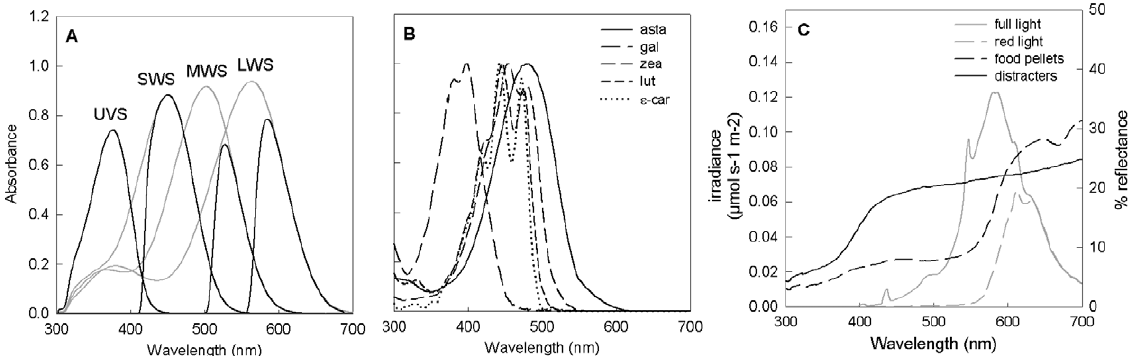
Figure 1. A comparison of carotenoid and visual pigment absorbance spectra, food and background reflectance, and irradiance spectra of the experimental lighting. (A) Absorbance spectra of single-cone photoreceptors before (gray lines) and after (black lines) carotenoid- pigmented cone oil-droplet filtering. Spectral sensitivities are based upon measures from the canary ( Serinus canaria ; [28]), the house finch’s closest relative for which these values are known. Microspectorphotometric studies [10] suggest that the long-wavelength-sensitive cone (LWS) is filtered by an oil droplet pigmented with astaxanthin, the medium-wavelength-sensitive cone (MWS) is filtered by a zeaxanthin-pigmented oil droplet, the short-wavelength-sensitive cone (SWS) is filtered by a galloxanthin-containing oil droplet, and the ultraviolet-sensitive cone (UVS) has a transparent oil droplet. (B) Normalized absorbance spectra of carotenoids found in the house finch retina: astaxanthin (asta), galloxanthin (gal), zeaxanthin (zea), lutein (lut), and e -carotene ( e -car). (C) Sample irradiance spectra from the full and red-filtered room lights and reflectance spectra of the food pellets and distracters. Irradiance spectra are presented in gray and are associated with the y-axis on the left. Reflectance spectra are presented in black and associated with the y-axis on the right.